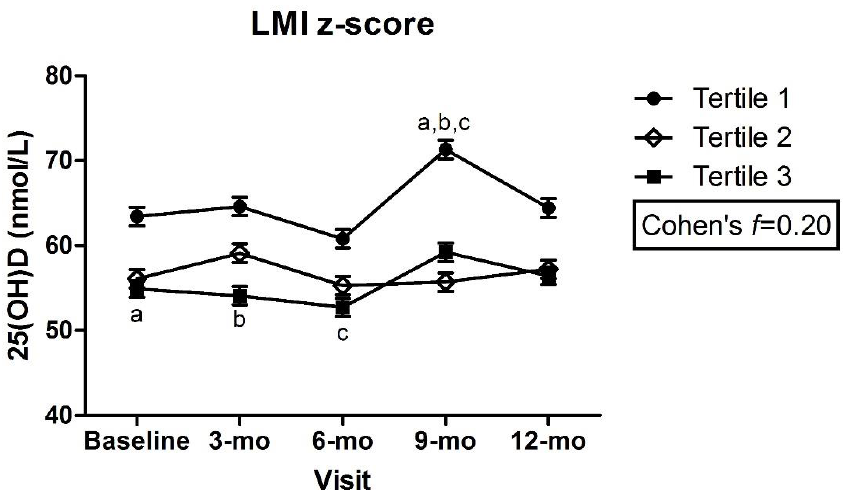
Figure 2. Plasma 25(OH)D across lean mass index z-scores by visit. Mixed effects model, mean ± SEM. Covariates include UVB exposure period, constitutive skin color, sunscreen use, dietary vitamin D intake. Values with same superscripts are significantly different from each other; p < 0.05, n = 101. Effect size reported as Cohen’s f . Abbreviations: 25(OH)D = 25-hydroxyvitamin D; LMI = lean mass index.